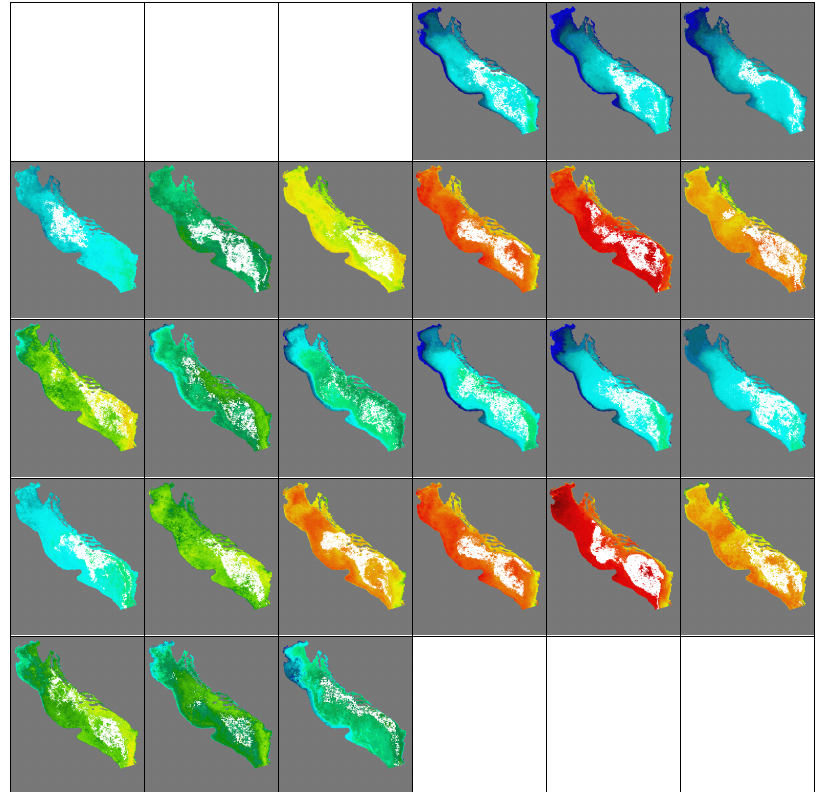
Fig. 4a. Spatial distribution of modal pixels for the period January 1999 - De- cember 2000. Each row, except for the first and last contains 6 months (i.e. two consecutive seasons) of the MW distribution (in white) plotted over the monthly median SST